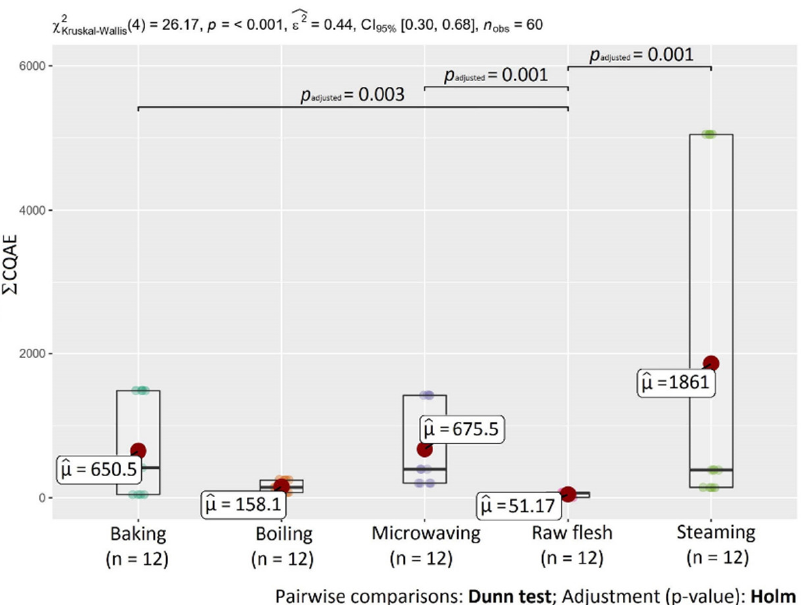
Figure 5. Statistical differences in the content of chlorogenic acid equivalents (ΣCQAE) between heat treatment methods.